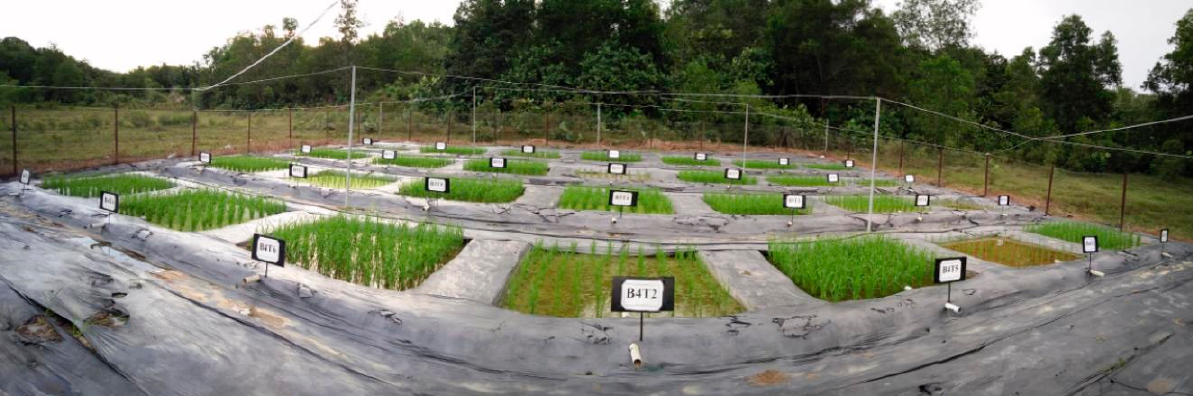
Figure 1. Aerial view of the rice plot at Universiti Putra Malaysia Bintulu Sarawak Campus, Malaysia.